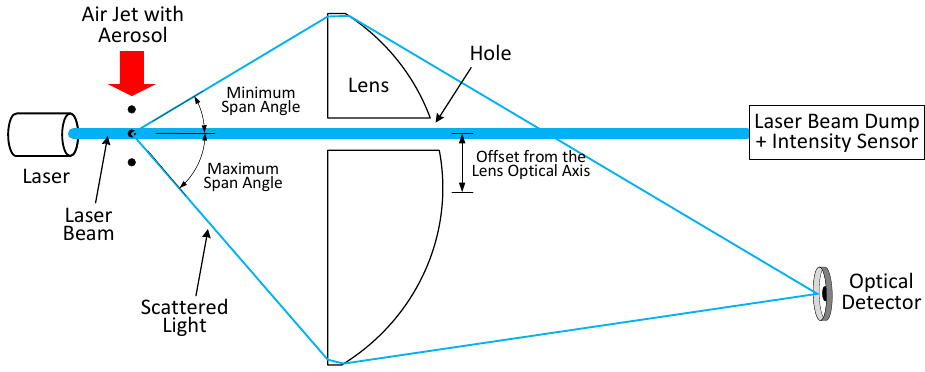
Figure 9. The layout of optical particle counter based on a drilled plastic lens. Adapted with permission from Ref. [79]. © 2021 American Association for Aerosol